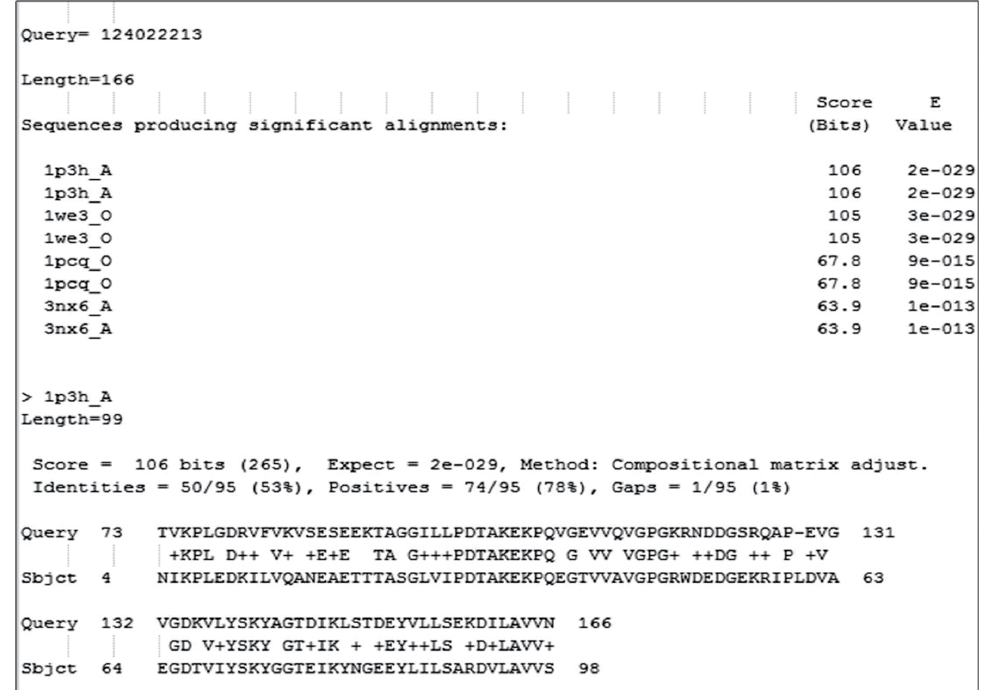
Figure 4: BLASTP search against PDB database and hypothetical protein P9303_05031.